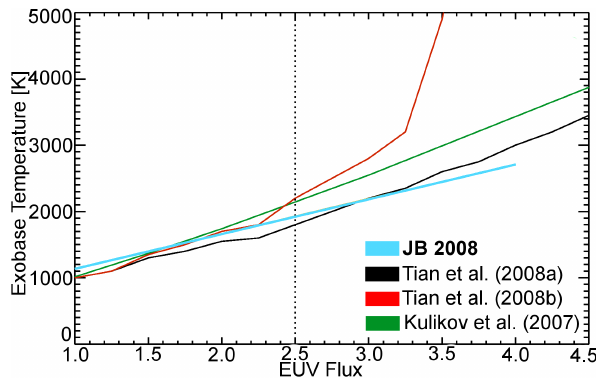
Fig. 8. Exobase temperatures obtained from the empirical thermo- sphere model JB08 and the theoretical models of Kulikov et al. (2007) and Tian et al. (2008a,b) under different solar EUV con- ditions. The vertical dotted line corresponds to the 2.5 × EUV en- hancement inferred from the X17.2 Halloween flare on 28 Octo- ber 2003; if continuously emitted it would correspond to a ∼ 2.3Gyr old